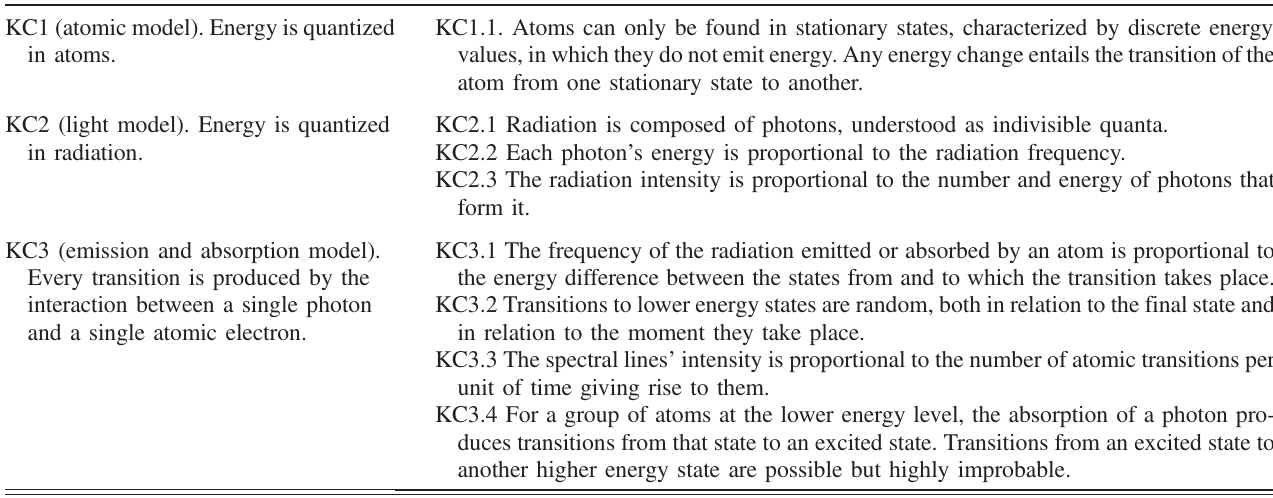
TABLE I. Key concepts that should be considered in any quantum model of emission and absorption of electromagnetic radiation to explain the gas spectra